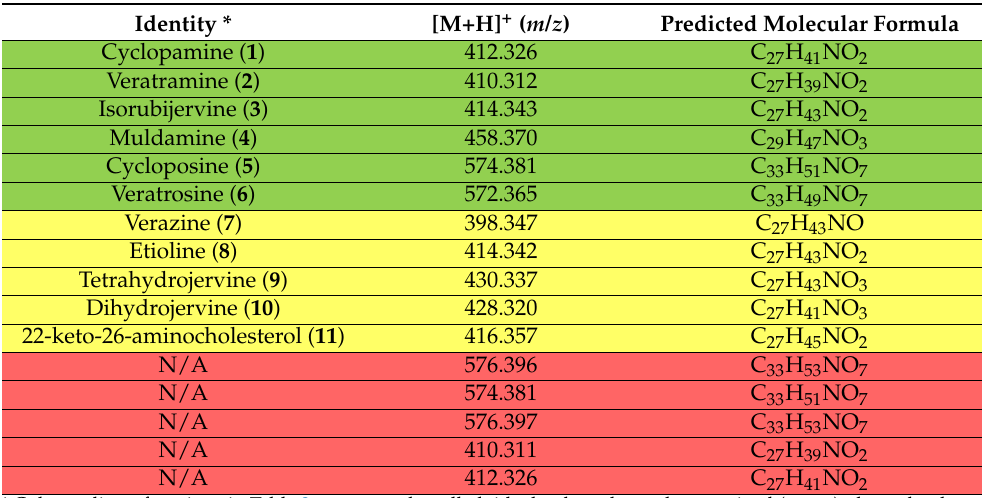
Table 2. Qualitative assessment of Veratrum californicum